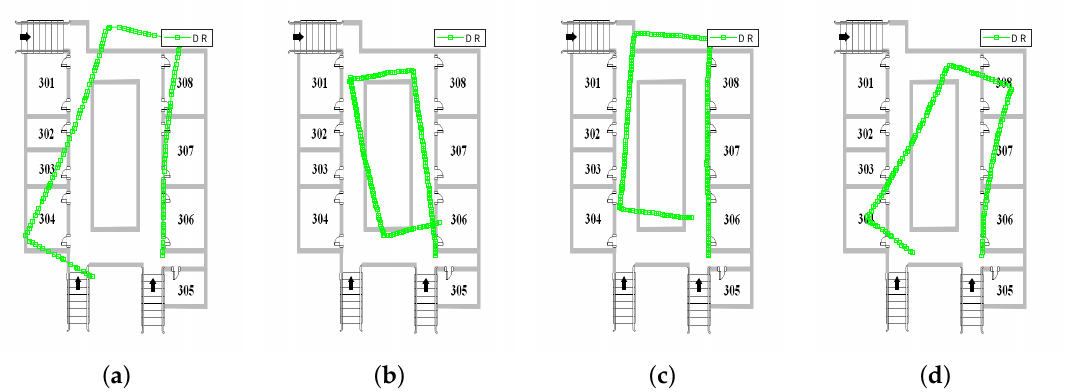
Figure 4. Positioning results for DR in teaching building: ( a ) calling; ( b ) dangling; ( c ) handheld; and ( d )